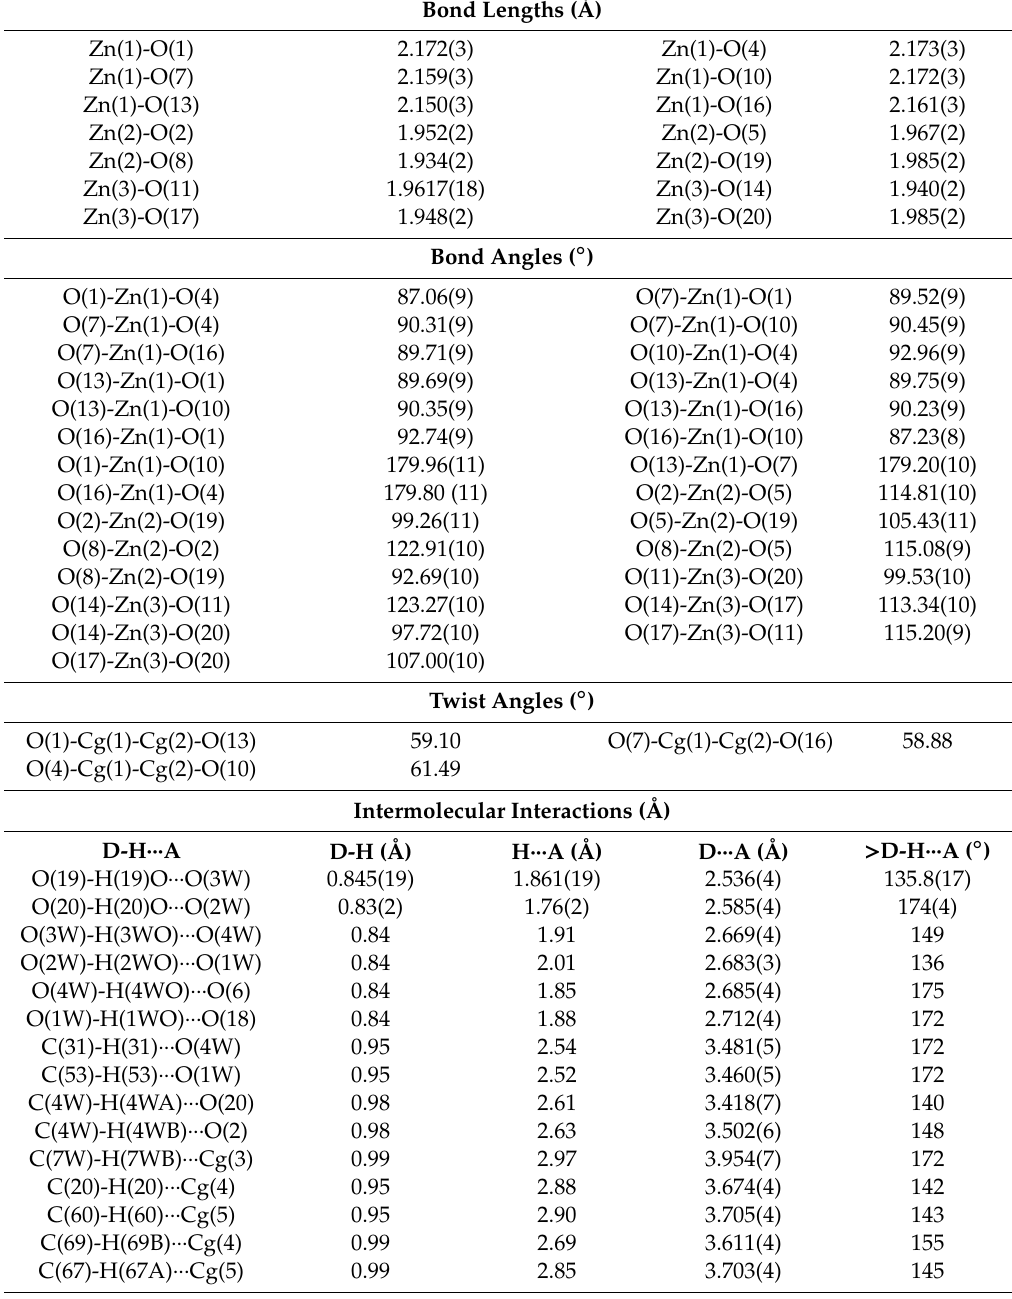
Table 3. Selected bond lengths (Å), bond angles ( ◦ ), and intermolecular interactions (Å) of compound 3 ·